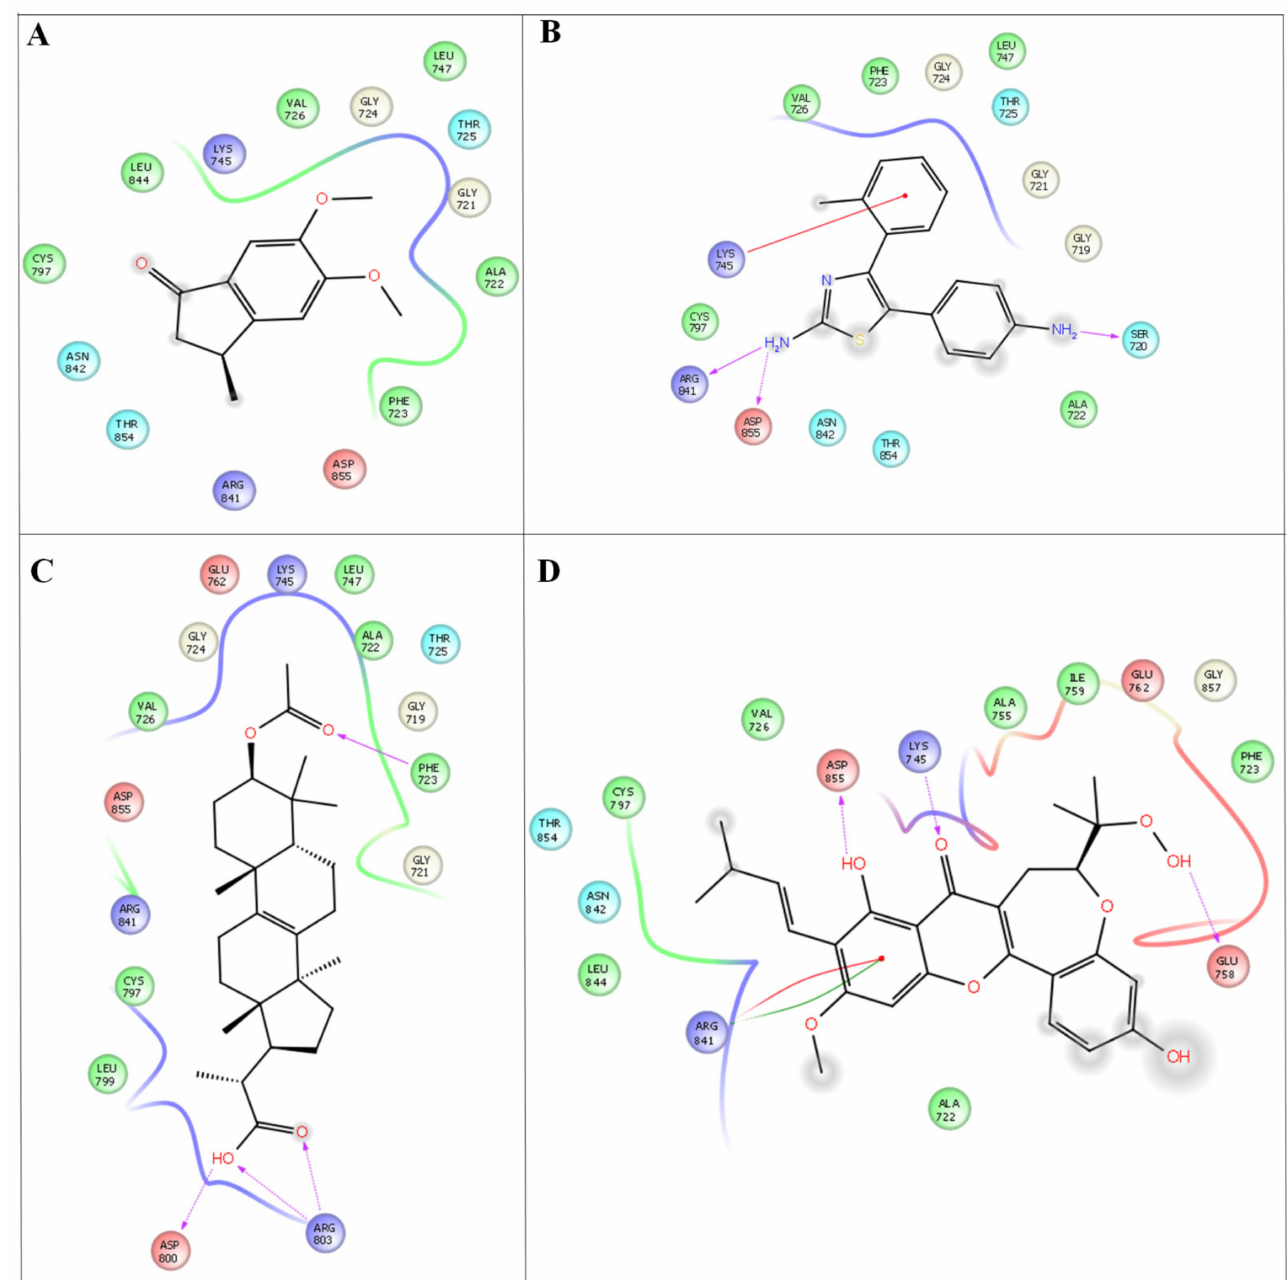
Figure 5. In silico molecular docking studies representing 2 dimentional Azima tetracantha complexes with ligand interac- tion. ( A ) 6-dimethoxy-3-methyl-2,3-dihydro-1h-indene-1-one interaction 2ITY Ligplot. ( B ) 5,6-dimethoxy-3- methyl-2,3- dihydro- 1H-indene-1-one. ( C ) 2-(3-acetoxy-4,4,10,13,14-pentamethyl-2,3,4,5,6,7,10,11,12,13,14,15,16,17- tetradecahydro-1H- cyclopenta [a]phenanthren-17-yl) propanoic acid. ( D ) 7-acetyl-3a1-methyl-4,14-dioxo- 1,2,3a,3a1,4,5,5a,6,8a,9b,10,11,11a- tetradecahydro-2,5a1-epoxy5,6a (methanooxymethano)phenaleno[1 (cid:48) ,9 (cid:48) :5,6,7] indeno [1,7a-b]oxiren-2-yl